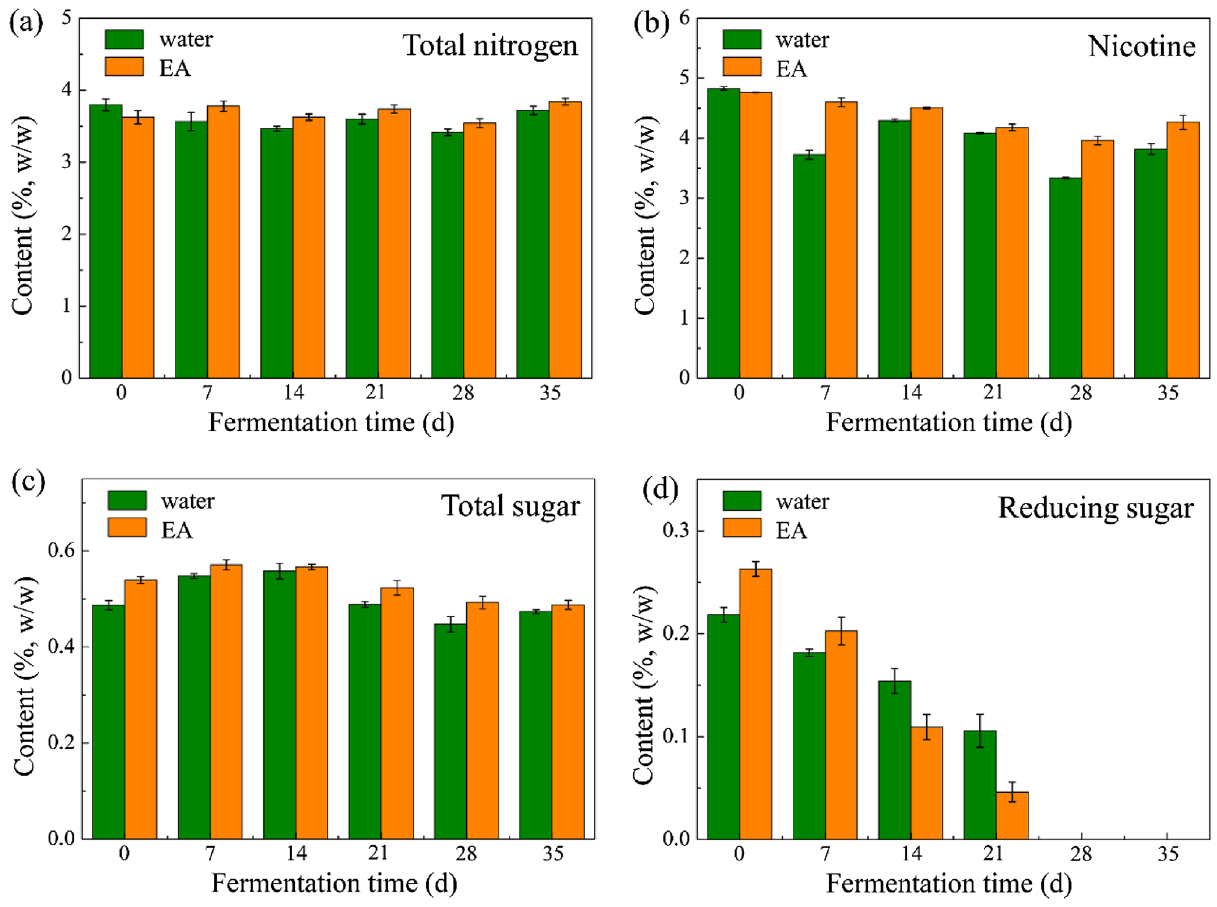
Figure 1. Contents of total nitrogen ( a ), nicotine ( b ), total sugar ( c ), and reducing sugar ( d ) of CTL samples in water- and